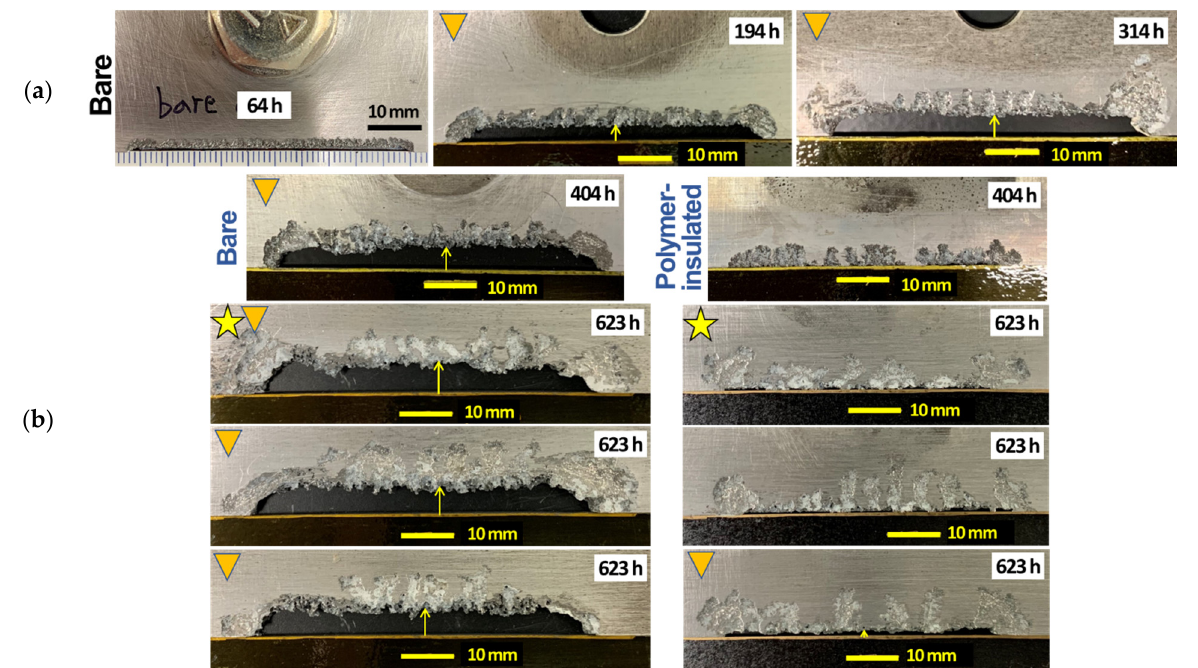
Figure 4. Post-immersion AZ31B sheets that developed corrosion volumes from ( a ) bare bolt joints with immersion time up to 314 h, and ( b ) bare and polymer-insulated joints with immersion times of 404 and 623 h. The triangle symbols indicate corrosion depth measurement, and star symbols indicate corrosion potential measurements in which the values at the completion of the immersion tests were − 1.26 and − 1.48 V SCE for the bare and polymer-insulated joint specimens, respectively.